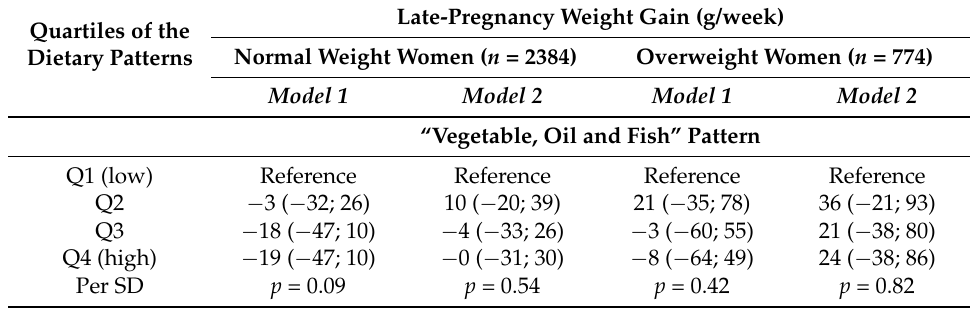
Table 5. Association of dietary patterns with gestational weight gain in late pregnancy ( n = 3158) 1